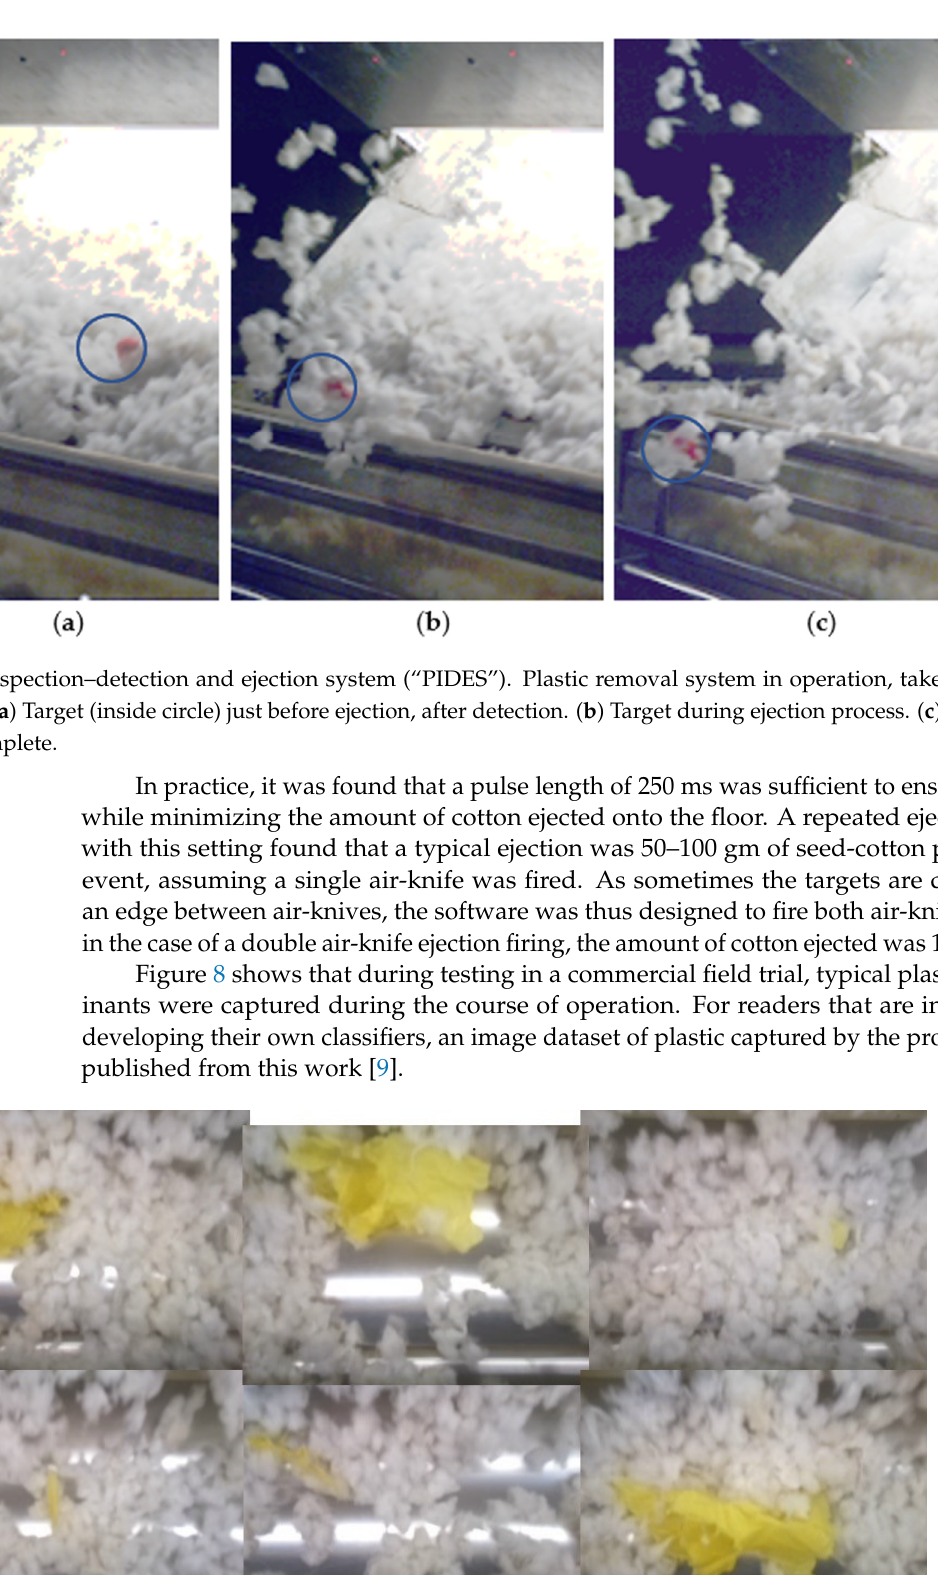
Figure 6. Plastic detection–ejection system installed and running at a commercial cotton gin.